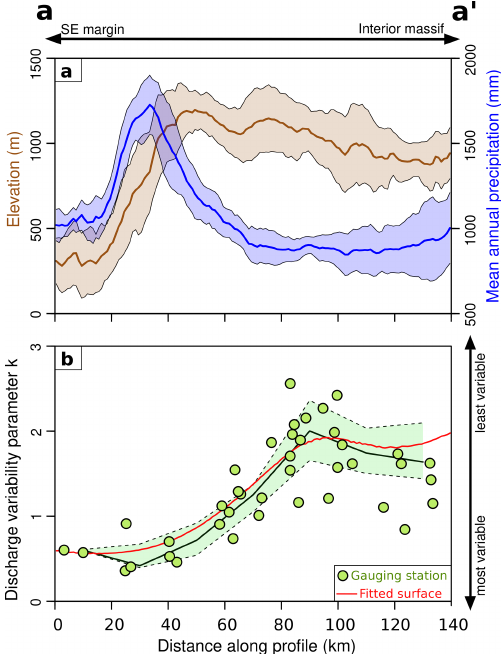
Figure 2. (a) Swath profile for elevation and mean annual precipi- tation (MAP) across the southeastern margin of the Massif Central (width 60km). The location of the profile is indicated in Fig. 1b. Solid lines and envelopes are the medians and interquartile ranges, respectively. (b) Values of the discharge variability parameter at gauging stations (green circles). The black solid line is the median along the same swath profile as the panel above. The envelope de- notes the interquartile range. The red line corresponds to the inter- polated thin plate spline surface (Fig.